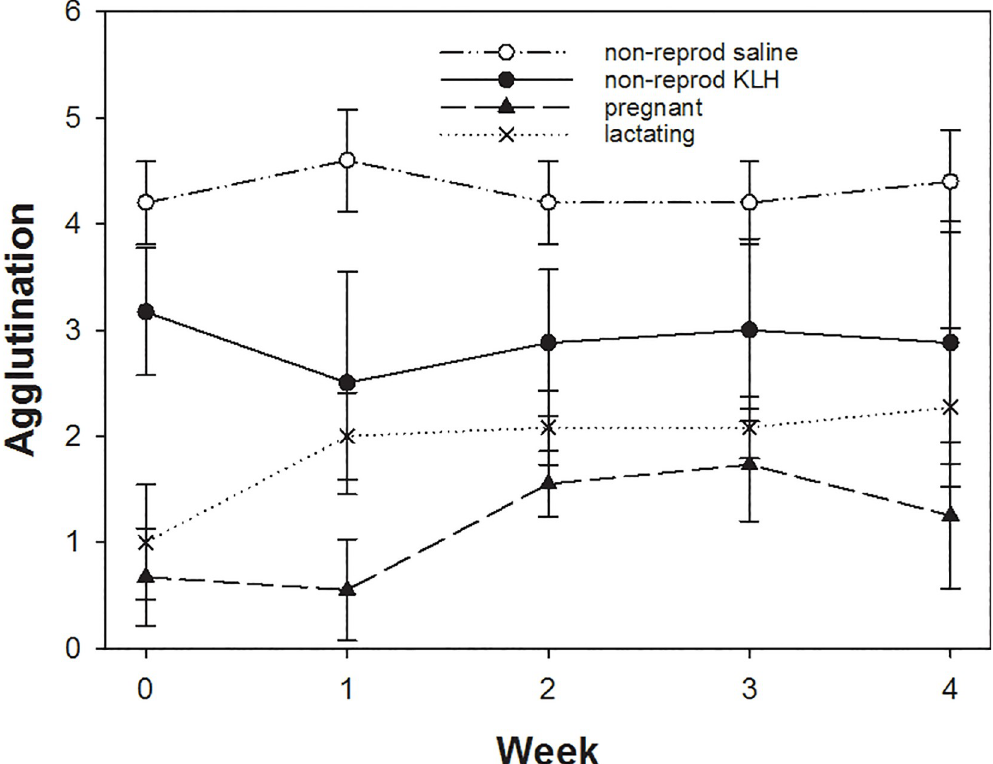
Fig 5. Differences in haemagglutination titers across the 4 weeks for non-reproducing, pregnant and lactating females. Plotted are means and SE. For details see